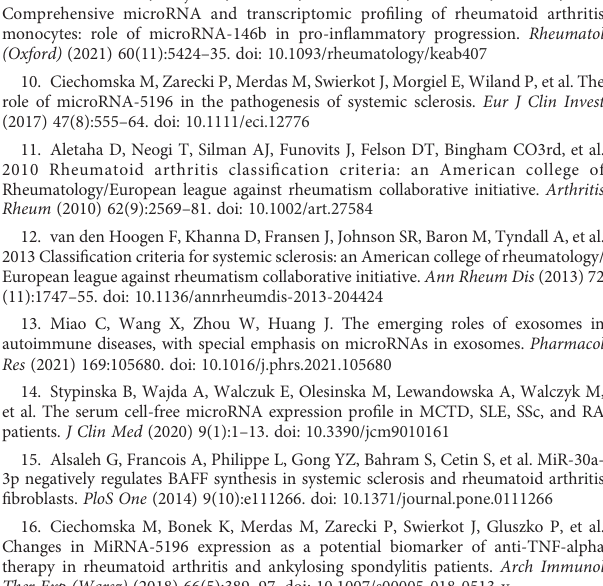
SUPPLEMENTARY FIGURE 2 The levels of circulating miRNA and CRP in RA patients upon baricitinib